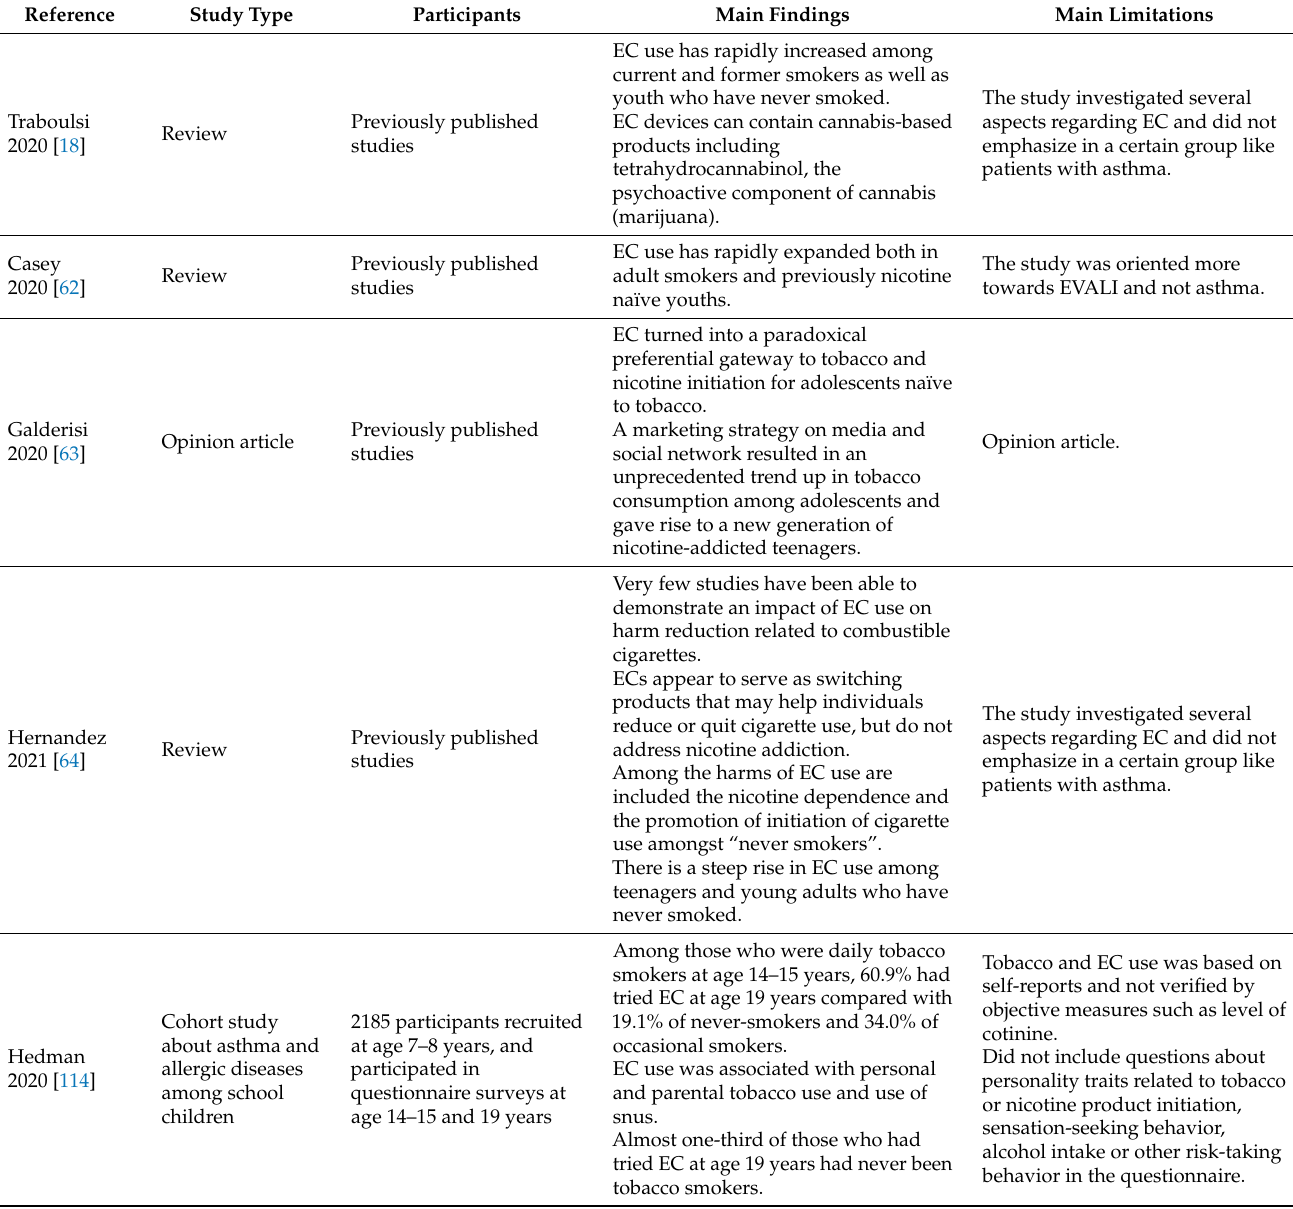
Table 3. Studies addressing research question 4: Is EC use an effective strategy for smoking cessation in patients with